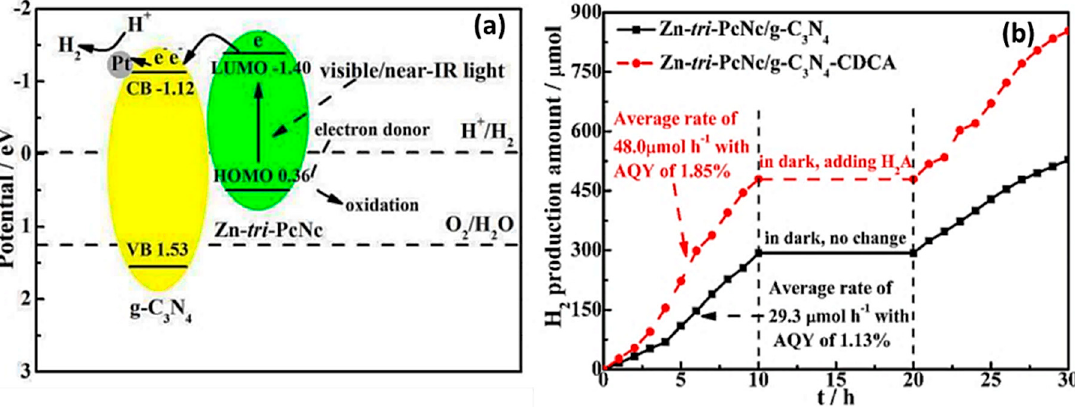
Figure 8. Photocatalytic-based H 2 production process ( a ) and stability for H 2 production ( b ) of Zn-tri-PcNc/g-C 3 N 4 materials.